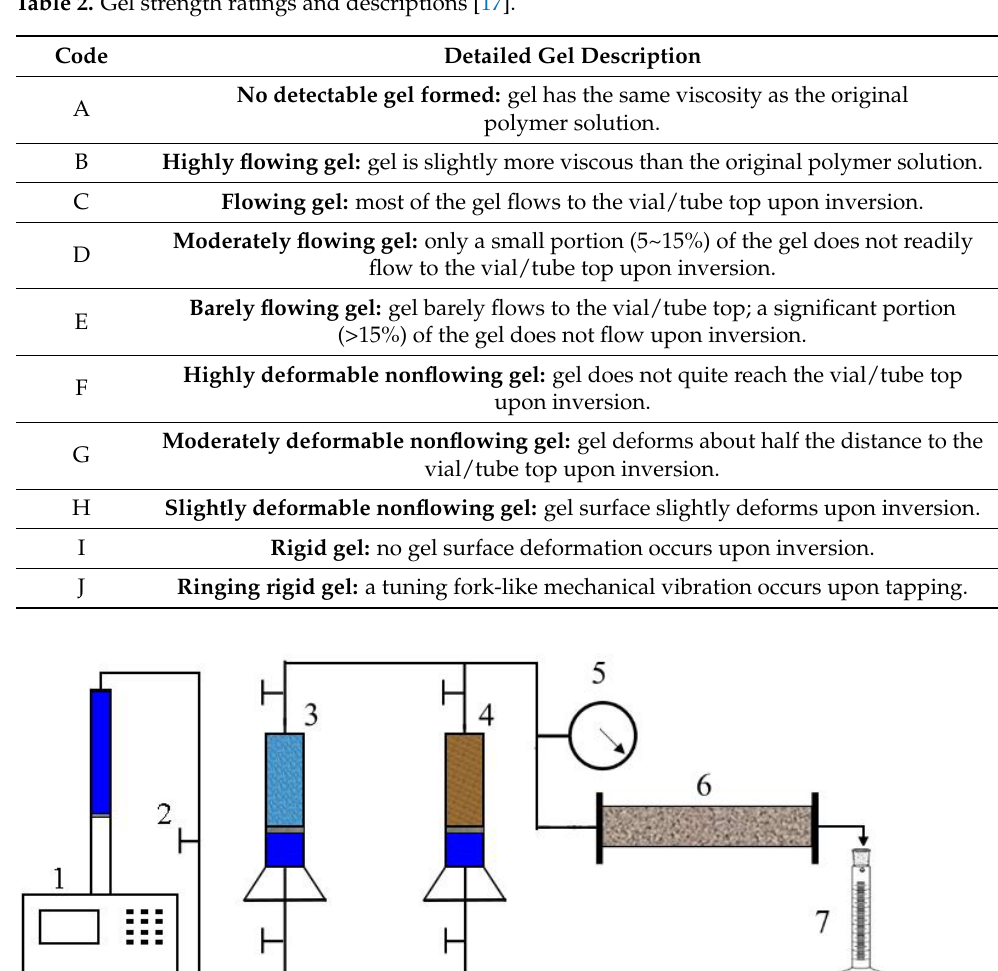
Table 2. Gel strength ratings and descriptions [17].